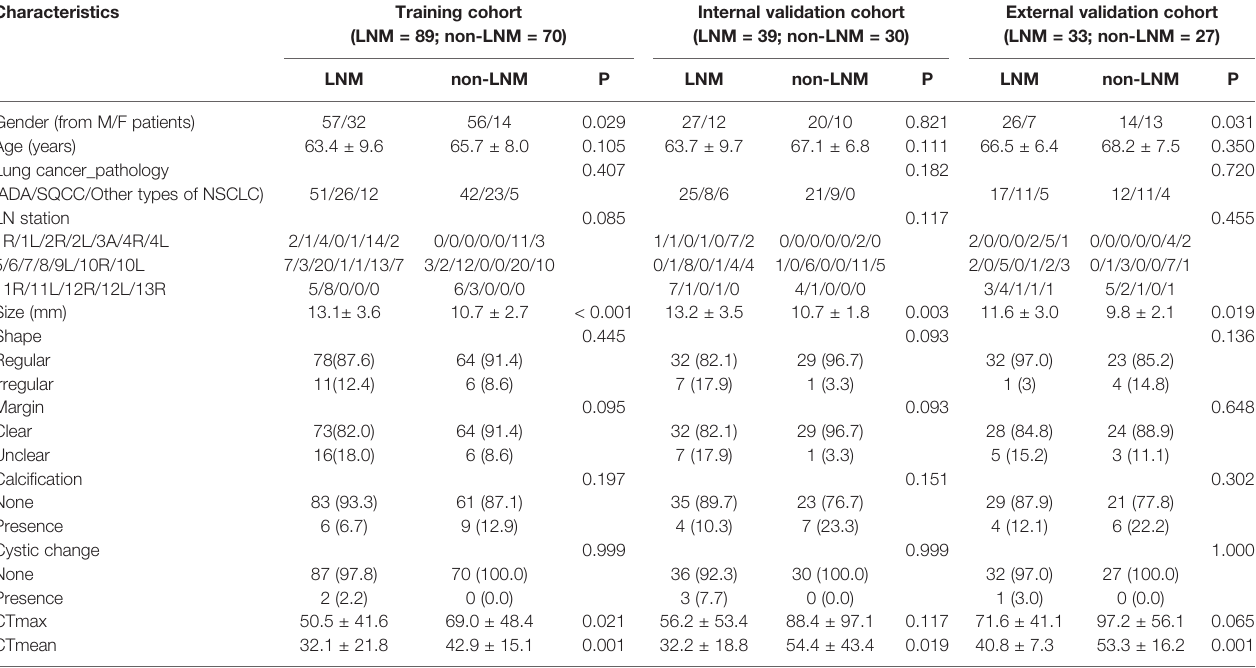
TABLE 2 | Comparison of CT image features and clinical data between LNM and non-LNM groups in the three cohorts.